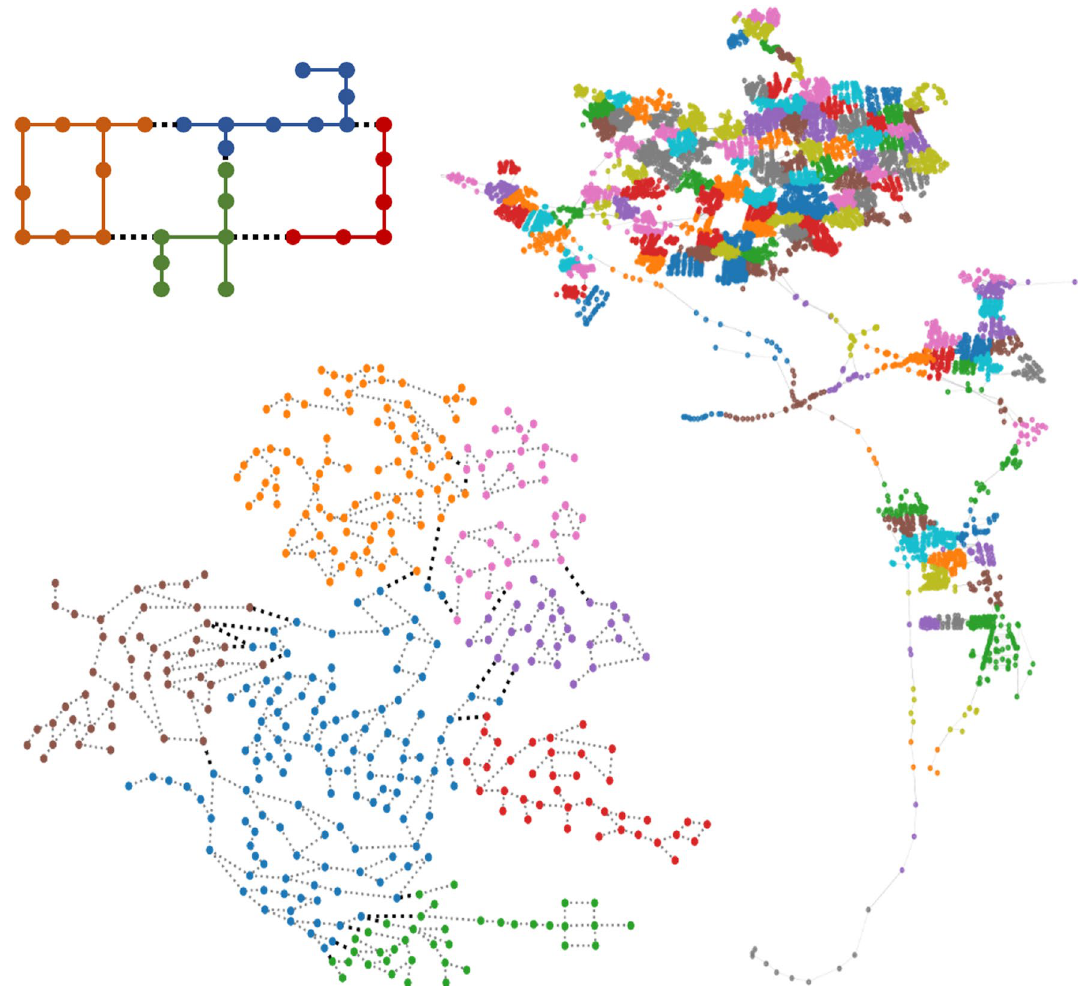
Fig. 4 Clustering results of Hanoi (upper left), C-town (lower left), and E-town